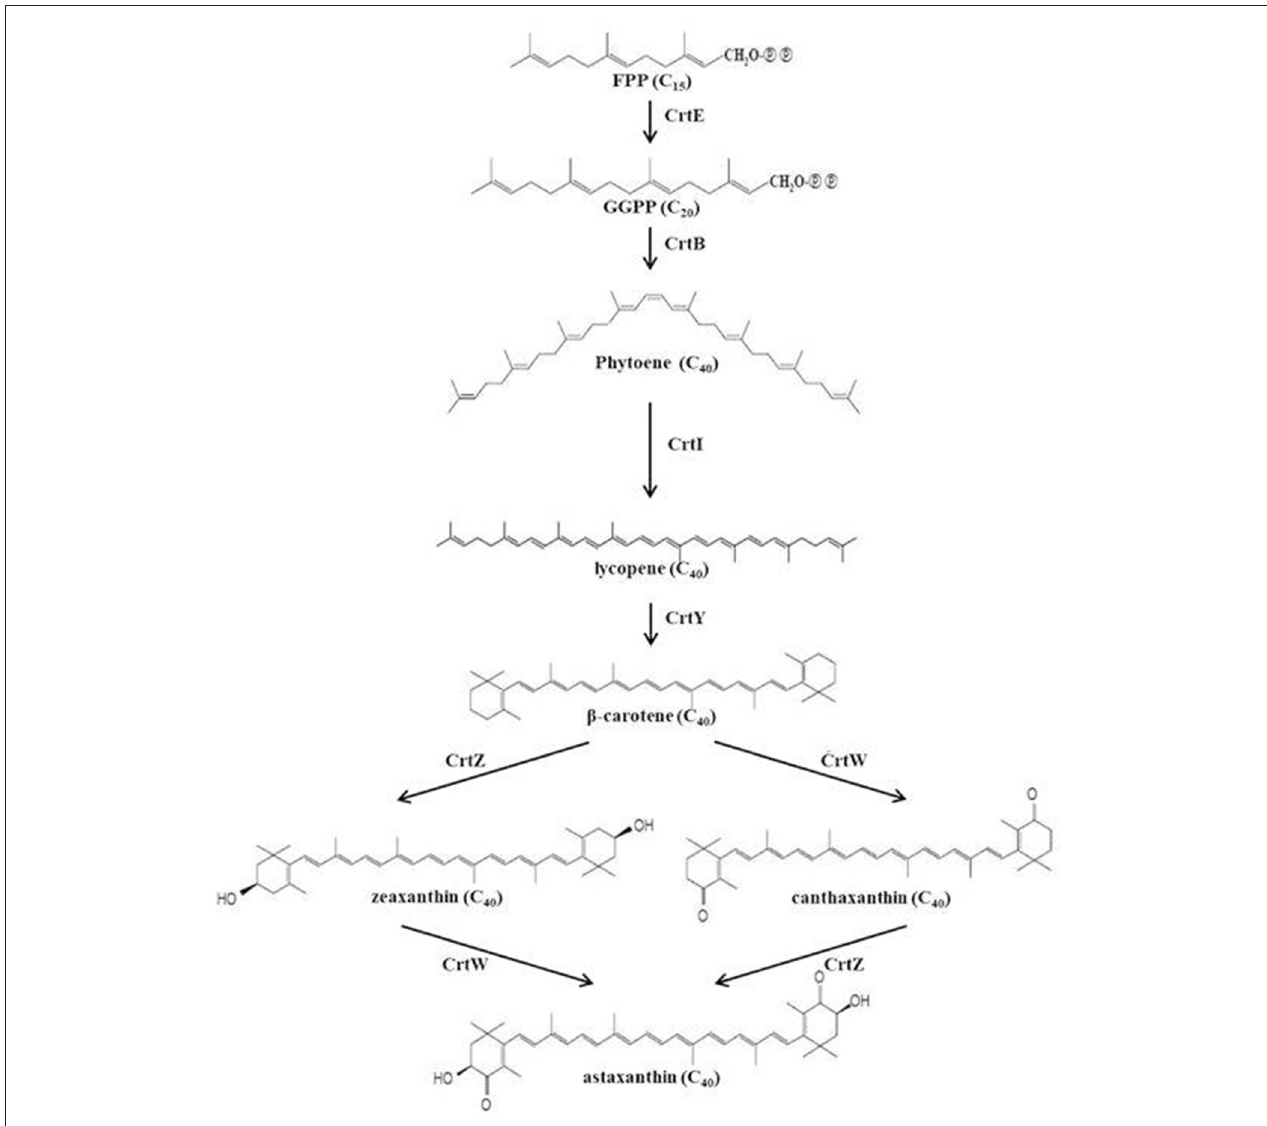
FIGURE 1 | Schematic of the carotenoid biosynthesis pathways of P. haeundaensis .